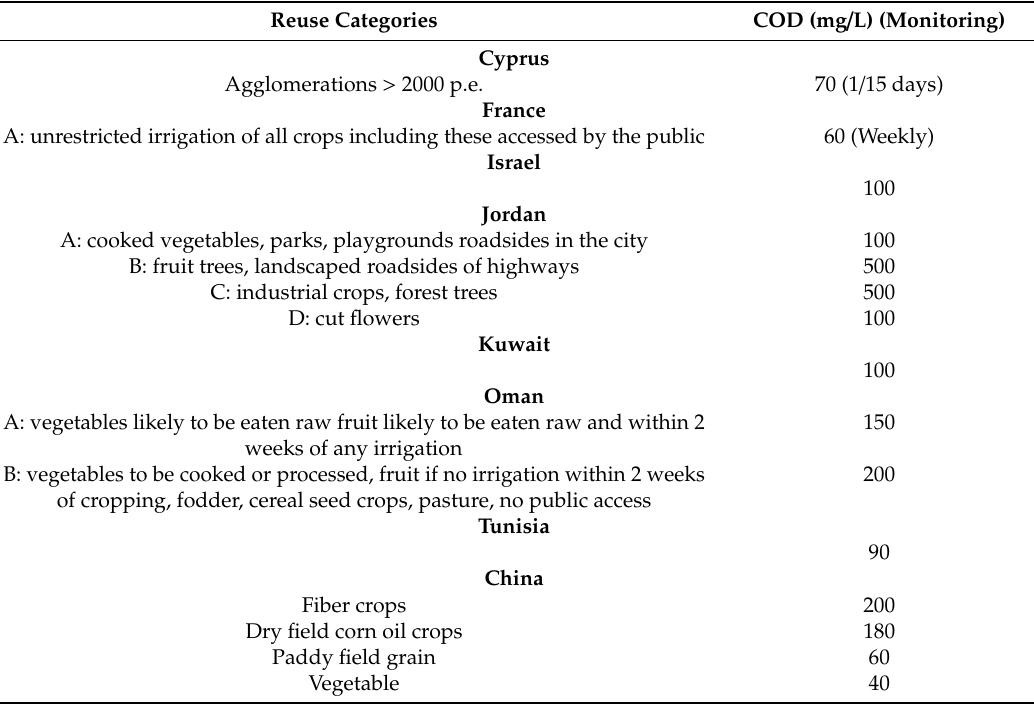
Table 19. COD thresholds in agricultural water reuse regulations and